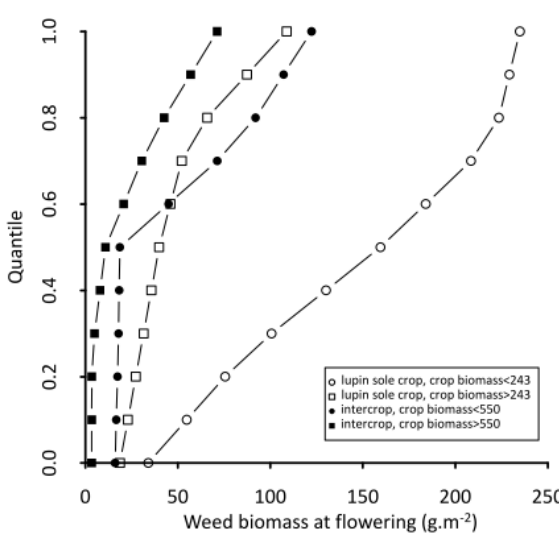
Figure 5. Distribution of weed biomass at lupin flowering across the 11 sites for di ff erent crop biomasses in the intercrop and in the lupin sole crop. Lupin sole crop and intercrop were separated in two pools according to median crop biomass so that for each cropping strategy, the sites with lowest crop biomass are represented with circles and the sites with highest crop biomass are represented with squares. Median crop biomass in the lupin sole crop: 243 g · m − 2 , median crop biomass in the intercrop: 550 g · m − 2 .